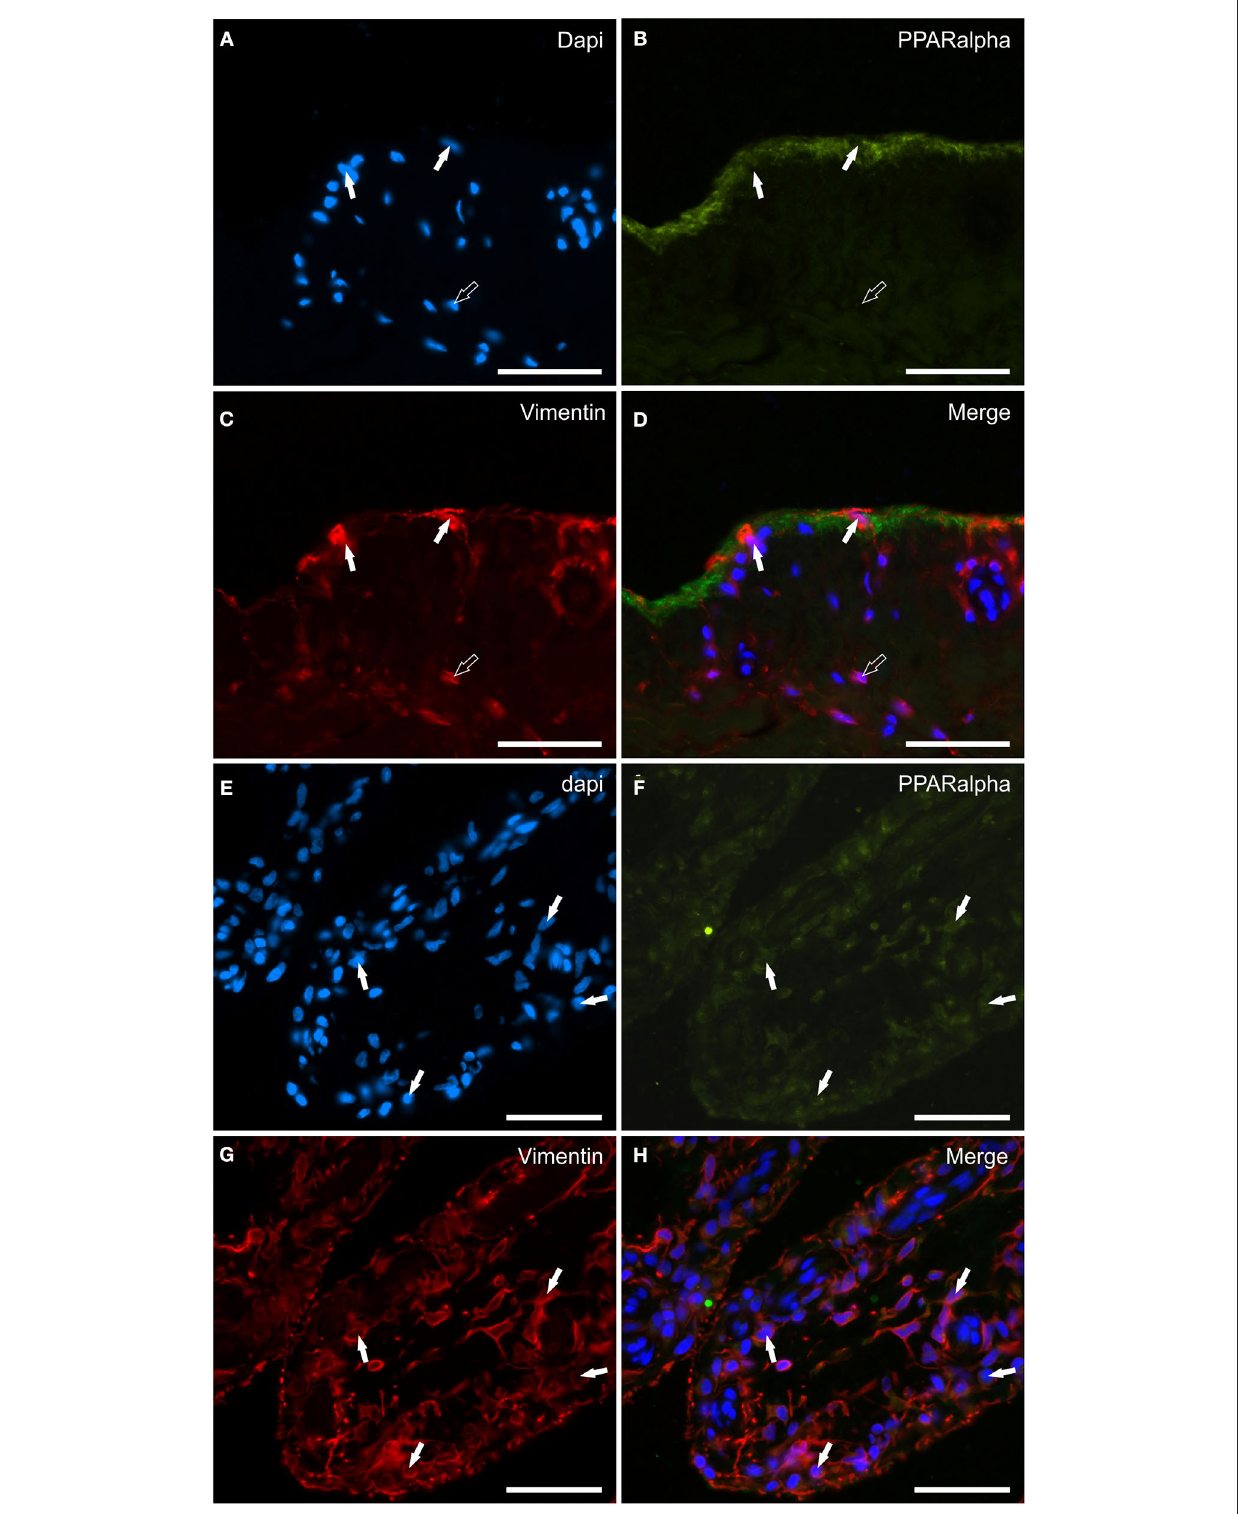
FIGURE8 Photomicrographs of the cryosections of the synovial membrane of a horse metacarpophalangeal joint showing peroxisome proliferator-activated receptor alpha (PPAR α ) immunoreactivity in synoviocytes (A–H) . (A–C) The white arrows indicate the DAPI (Blue) labeled nuclei of synoviocytes brightly immunolabelled with the anti-vimentin (Red) antibody which expressed faint-to-moderate PPAR α (Green) immunoreactivity. It is possible to see the indistinct PPAR α immunostaining of the upper portions of the cells lining the joint cavity. (E–H) The figures show the longitudinal sections of two villi of the synovial membrane in which the arrows indicate the DAPI (Blue) labeled nuclei (E) of the cells, likely fibroblast-like synoviocytes and fibroblasts, co-expressing faint-to-moderate PPAR α -(Green) (F) and bright vimentin-(Red) (G) immunoreactivity. (D, H) Merged images (Orange). Scale bar = 50 µ